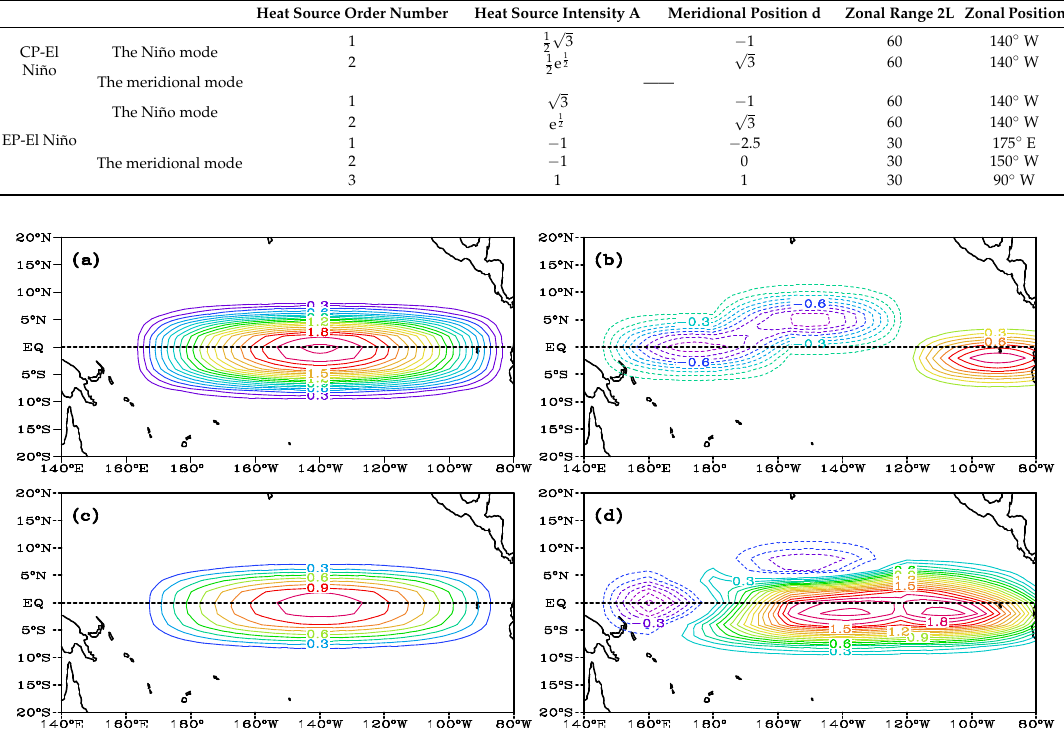
Figure 8. The heat source distribution of the first two modes ( a is the Niño mode, and b is the meridional mode) and the models of heat source distribution of two types of El Niño ( c is CP-El Niño; d is EP-El Niño). The continents are shown just for geographical reference.